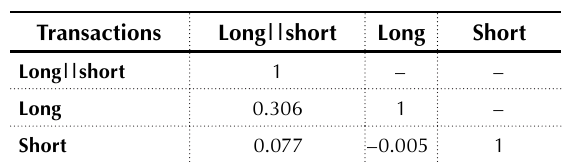
Table 10. Table of correlation coefficients between backtesting periods of the three PIVOT systems on